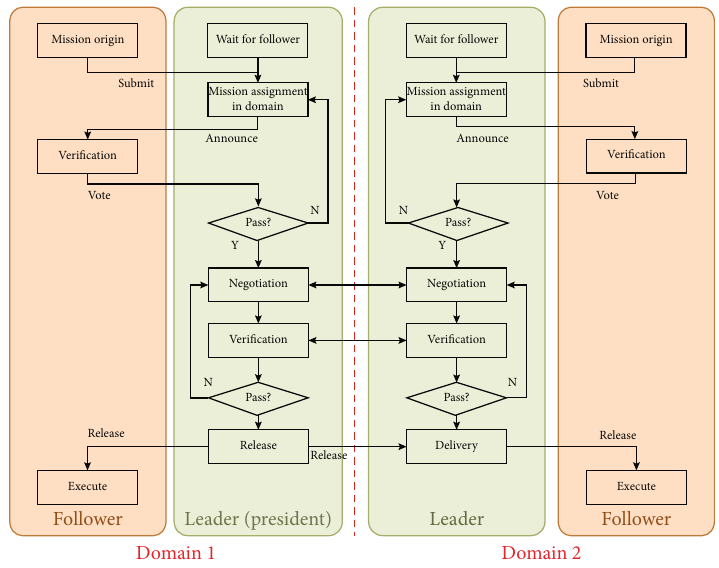
Figure 4: MAS mode process.